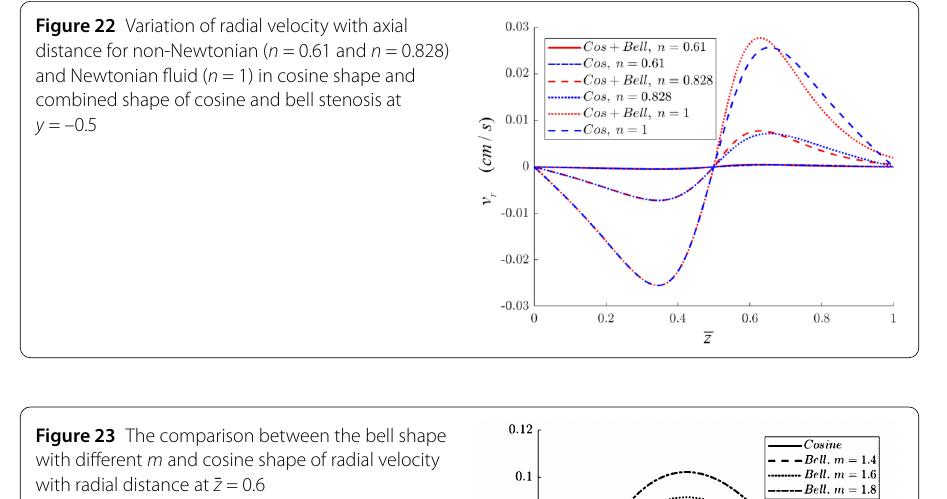
Figure 23 The comparison between the bell shape with different m and cosine shape of radial velocity with radial distance at ¯ z = 0.6